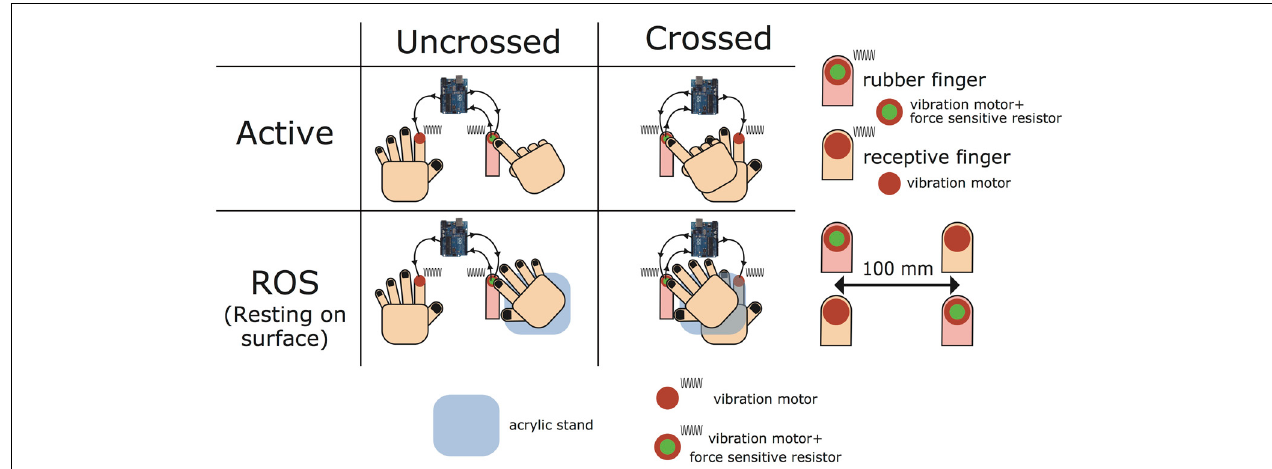
FIGURE 1 | Four types of hand postures in Experiment I. There were four types of hand postures in Experiment I. Uncrossed/crossed determines whether hands are crossed or uncrossed with a distance of 10cm. In active condition, the rubber finger was pressed by a right index finger while the rest of the four fingers in the right hand was wrapped, and the right elbow was kept in the air so that the right hand would not